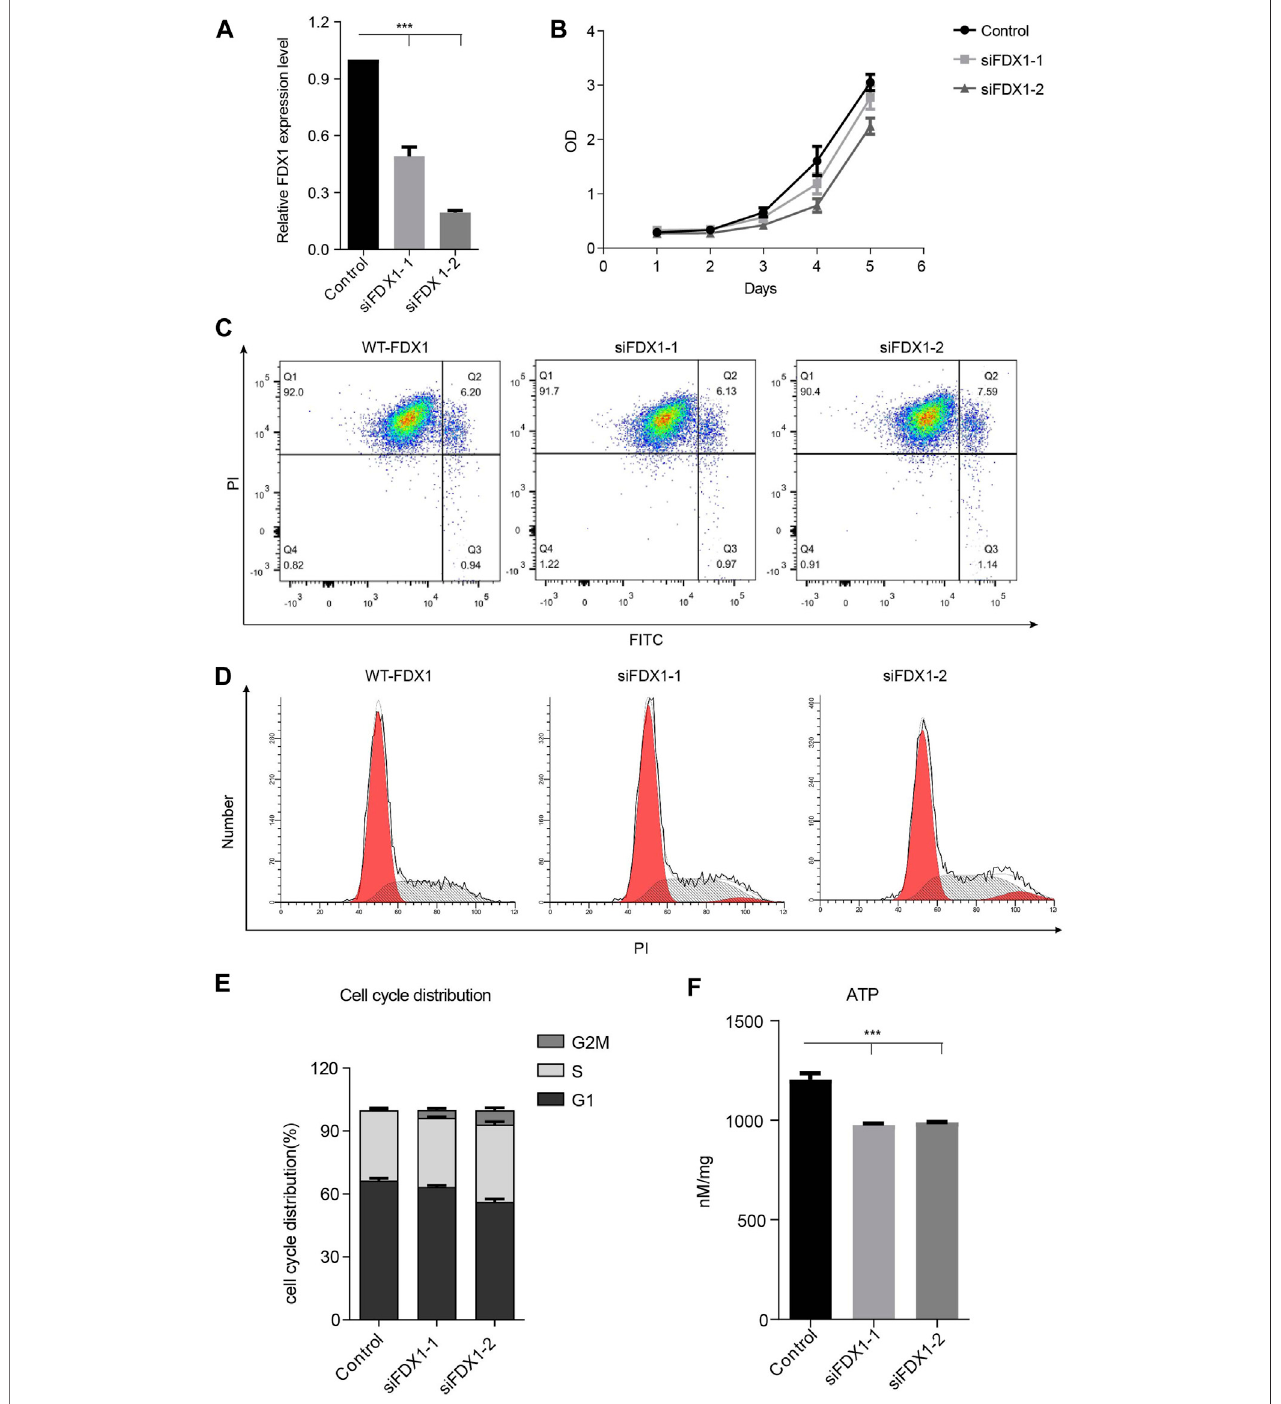
FIGURE 5 | Biological function of FDX1 in A549 cells. (A) . Expression of FDX1 in A549 cells transfected with si-FDX1. (B) . The cell growth of the FDX1 de fi ciency group and control group was assessed by the CCK-8 assay. (C) . The apoptotic rate of the control group and FDX1 de fi cient group. (D) . PI staining was used to detect thecellcycledistributionofthecontrolgroupandFDX1-de fi cientgroup. (E) .ThecellcycledistributionofFDX1-knockdowncellsandFDX1-wild-typecells. (F) .ATPlevels of FDX1-de fi cient cells and wild-type A549 cells.